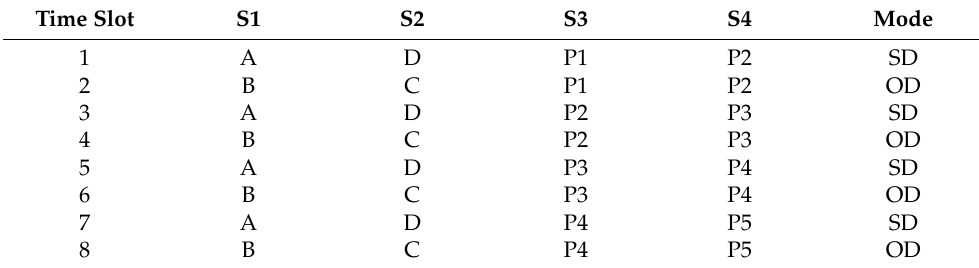
Table 1. Chart of switching the multiplexers.